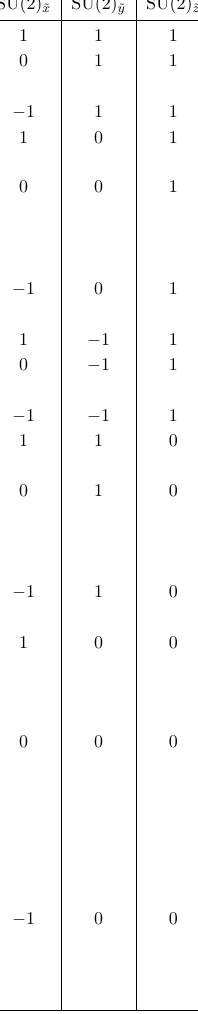
Table 49 . The generators in terms of bifundamental chiral fields for Model 12 (Part 1)